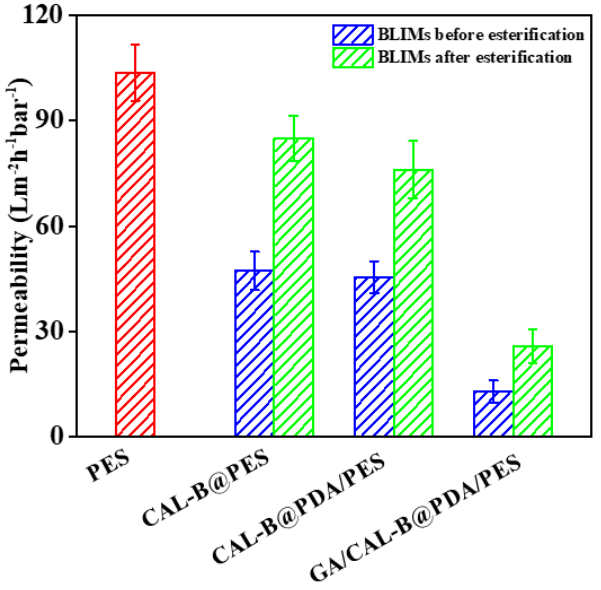
Figure 12. Permeability of BLIMs before and after esterification.